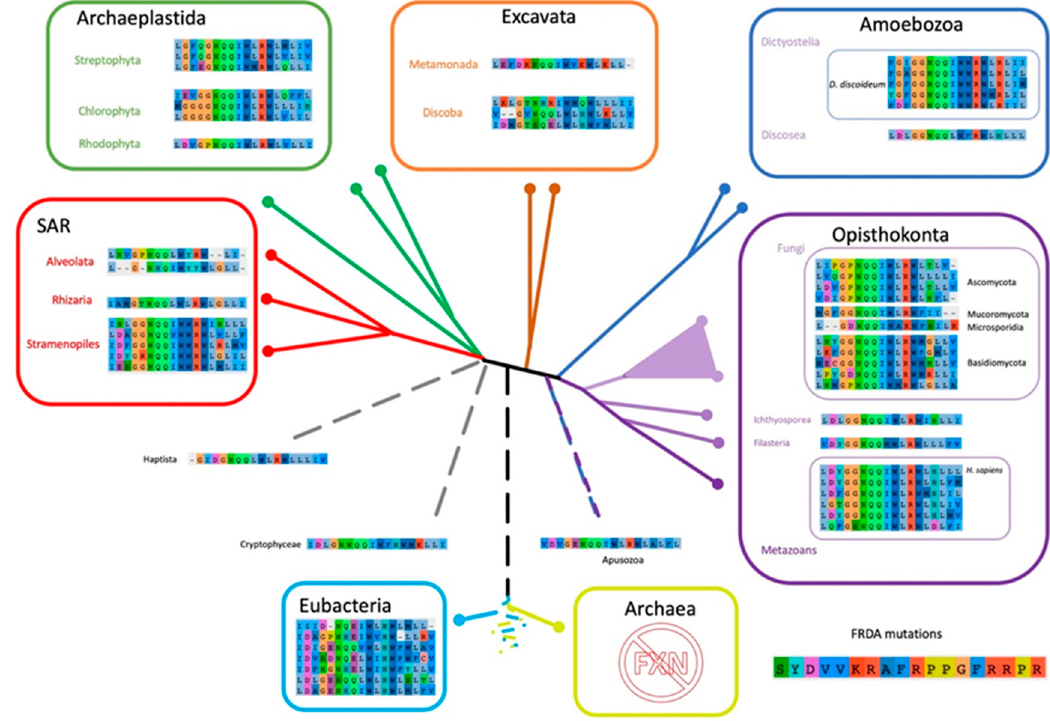
Figure 10. Scheme of Eukaryotic Phylogeny Showing the Corresponding Residues Involved in FRDA Across the Tree of Life. Eukaryotic phylogeny based on Adl et al. [56]. The FXN positions associated to Friedreich’s Ataxia are shown for each representative species selected in FXN phylogeny (All54G_cured_alignment.aln, Figure S5).